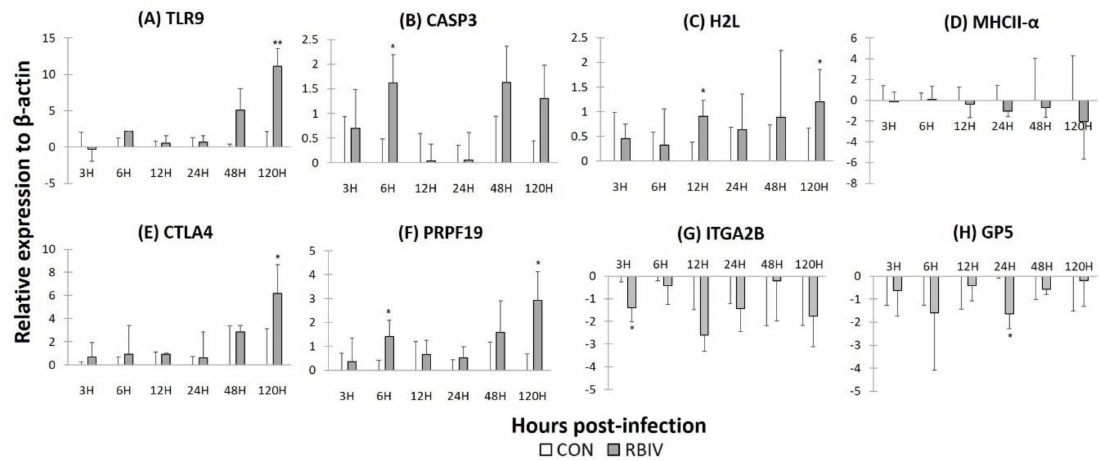
Figure 5. Relative expression levels of genes related to pattern recognition receptor (PRR) ( A ), apoptosis ( B ), antigen presentation ( C , D ), immune ( E ), hub gene, and ( F ) platelet activation ( G , H ) in blood cells of rock bream after RBIV inoculation. The expression level of β -actin was used as an internal control. Each experiment was performed in triplicate. Each bar and error bar represent log 2 FC value and standard deviation (SD), respectively. (*) and (**) indicate p < 0.05 and p < 0.01, respectively, relative to